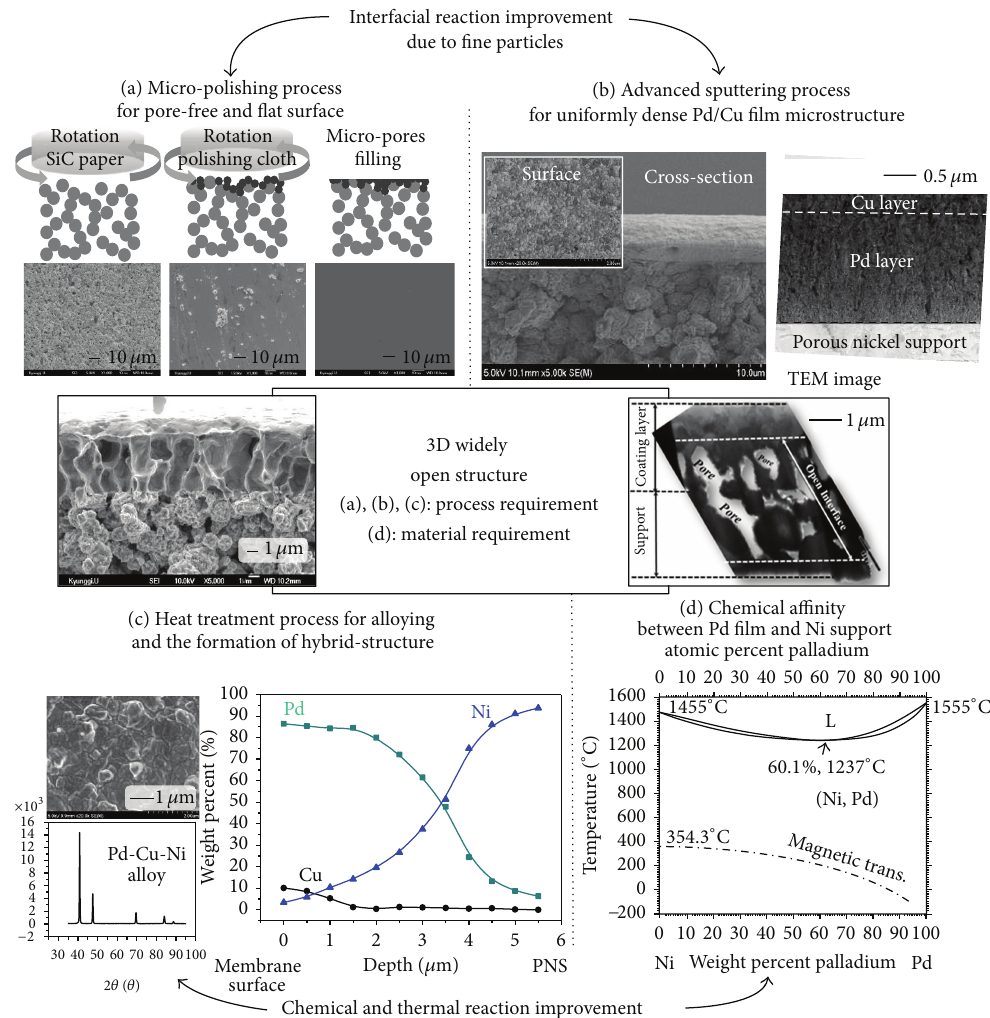
Figure 2: Process and mechanism for the formation of 3D widely open structure: (a) micropolishing process for pore-free and flat surface of the support (SEM images); (b) advanced sputtering process for uniformly fine films (SEM/TEM images); (c) heat treatment process for alloying, crystallization, and the formation of a dense/porous hybrid structure (SEM/XRD/EDS profile); (d) Pd-Ni alloy phase